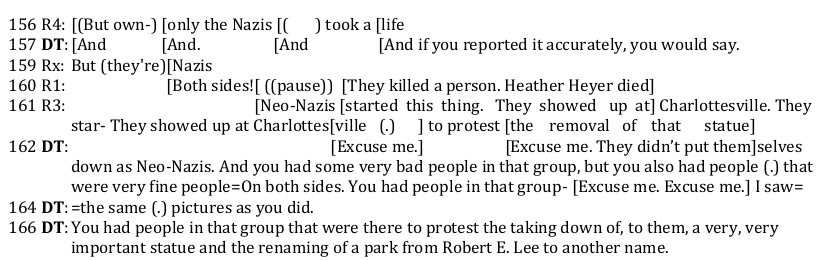
Figure 15. Transcript excerpt 156–166.